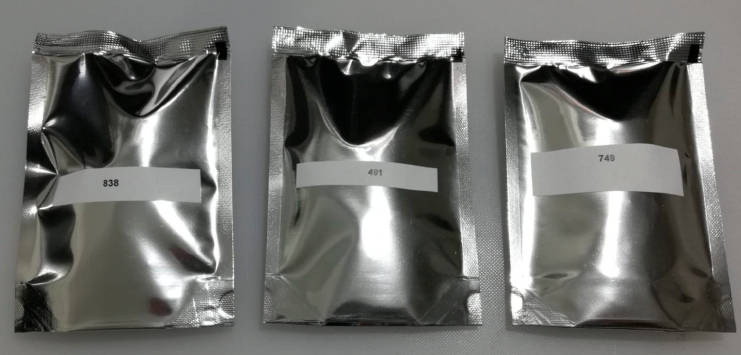
Figure 1. Randomly coded aluminium foil pouches containing the dried apple